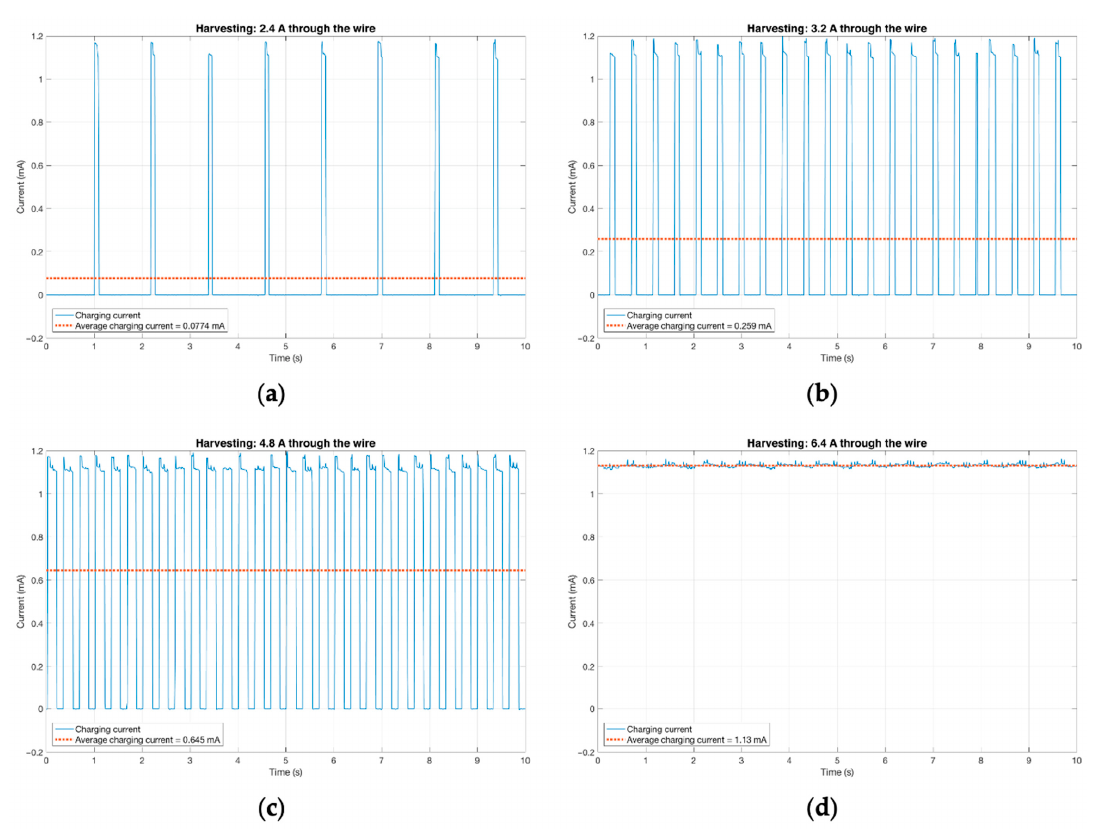
Figure A4. Current injected into the battery: ( a ) 2.4 A in the mains wire; ( b ) 3.2 A in the mains wire; ( c ) 4.8 A in the mains wire; ( d ) 6.4 A in the mains wire.